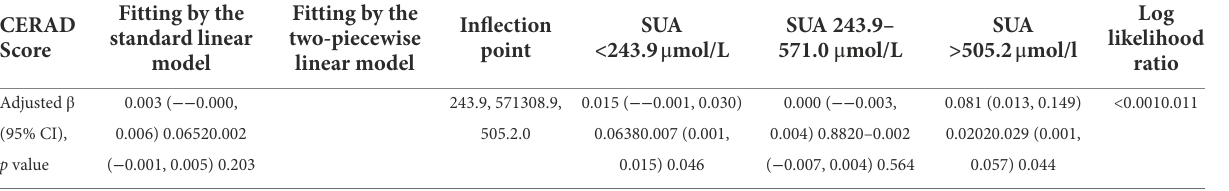
Age, gender, race, education, marital status, ratio of family income to poverty, albumin, creatinine, body mass index, diabetes, heart failure, stroke, hypertension, alcohol consumption, and physical activity were